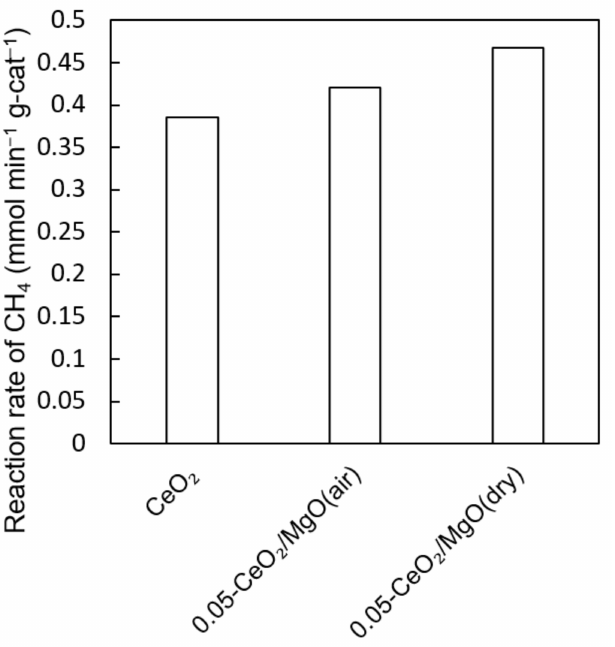
Figure 9. Average reaction rates of CH 4 of 6-h dry reforming reaction over CeO 2 and CeO 2 /MgO. The temporal variation of the CH 4 conversion rate also depended on the